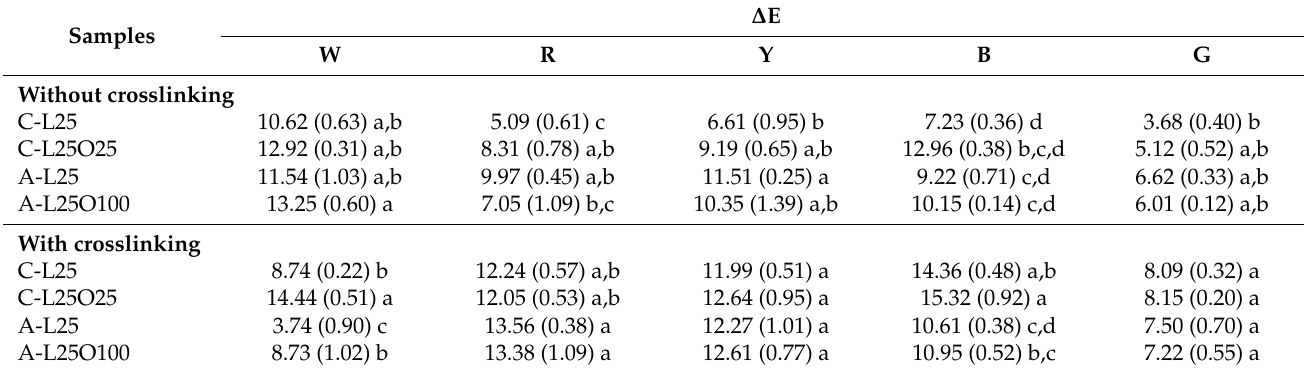
Table 3. Colour alterations of coloured paper sheets after being covered by selected films. Standard colours: white (W), red (R), yellow (Y), blue (B), green (G). ∆ E Values are expressed as means ( ± standard deviation). Means in each column with the same letter are not significantly different according to Tukey’s test ( p < 0.05).